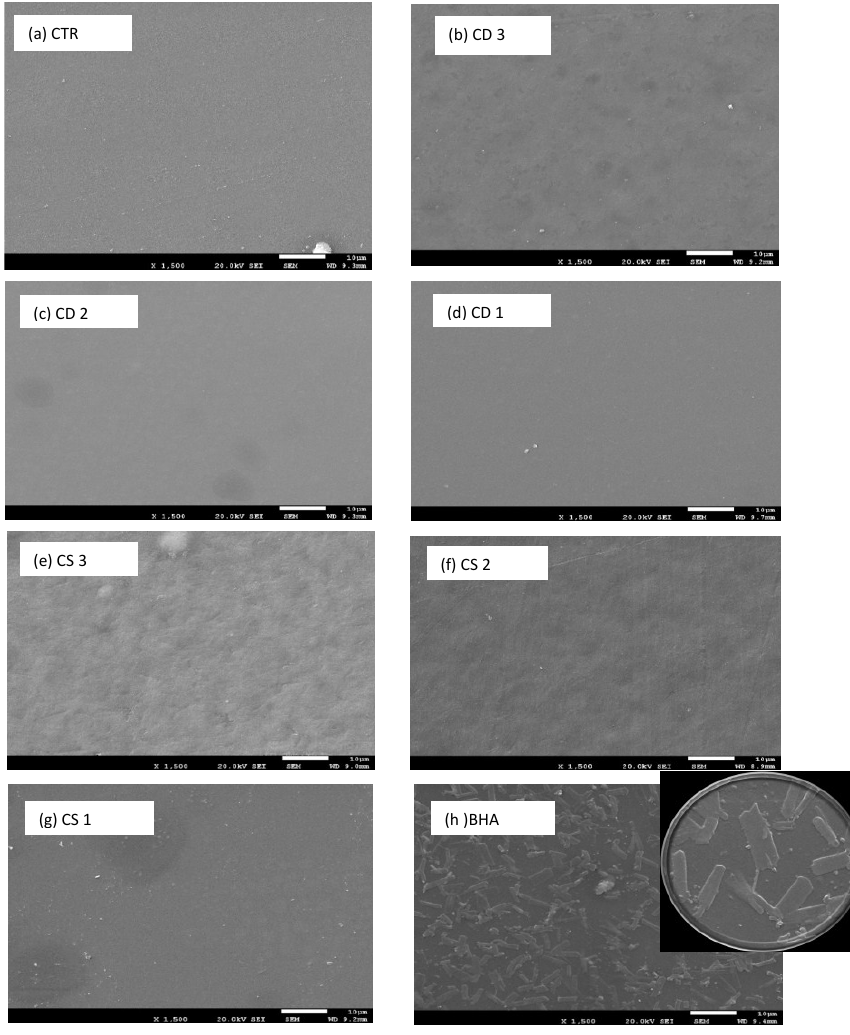
Figure 3. Scanning electron microscopy of gelatine films with different concentrations of plant extracts (1500×).